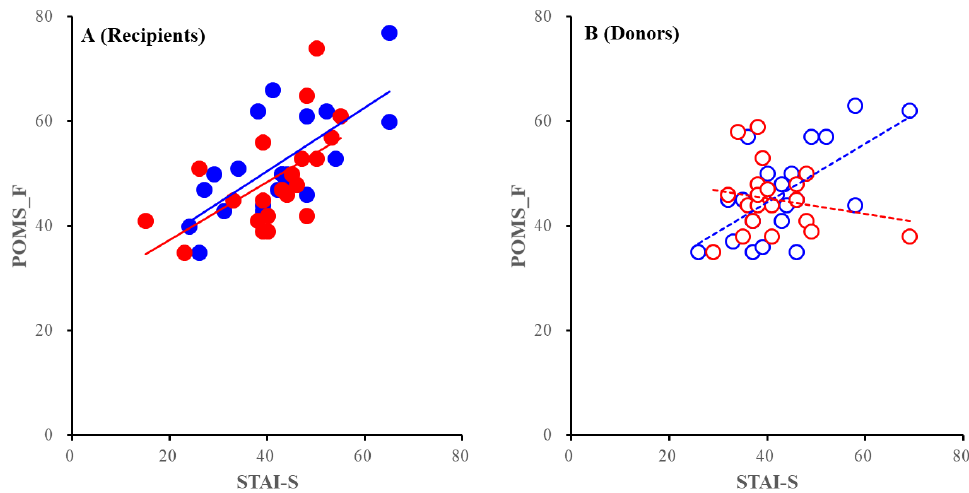
Figure 4. Correlation between the POMS-TA and STAI-T of recipients ( A ) and donors ( B ). Blue and red circles indicate PEKT, and PDKT, respectively. Closed and opened circles indicate recipients and donors, respectively. Full and dotted lines indicate the regressions of recipients and donors, respectively. Ordinates and abscissas indicate the mean ± SD of the POMS-TA, and STAI-T scores, respectively.